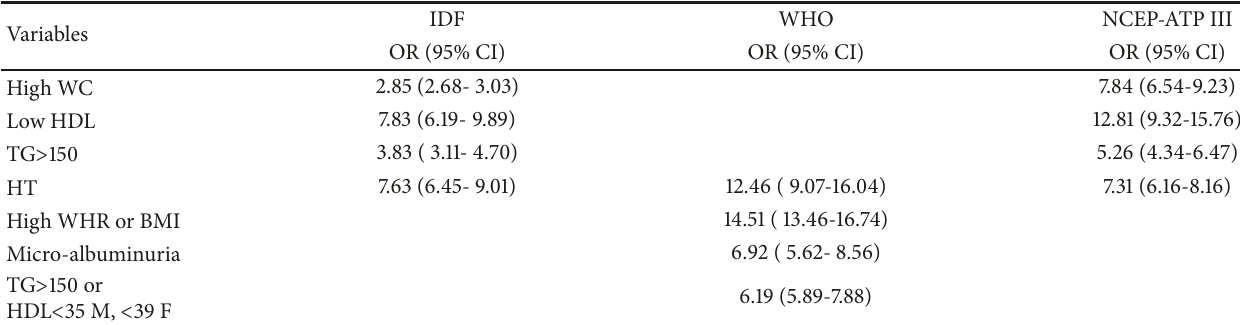
Table 4: Association between individual components and metabolic syndrome according to the three definitions.